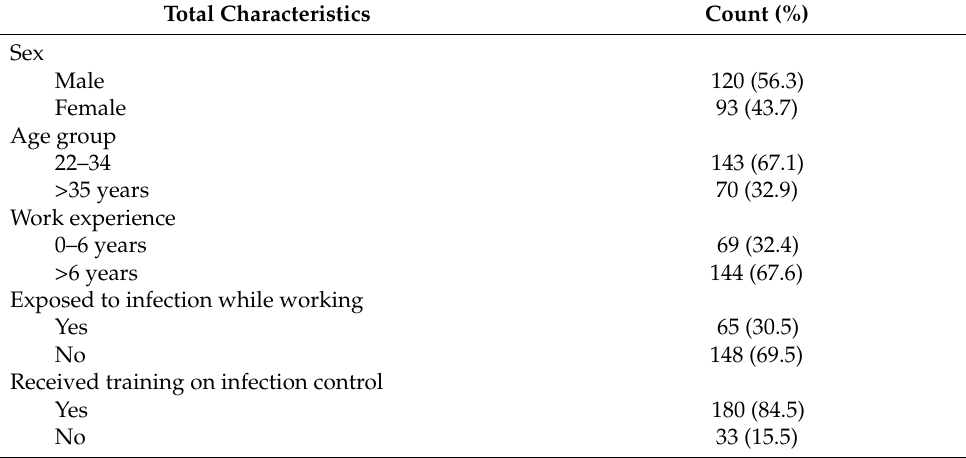
Table 1. Socio-demographics characteristics of HCWs, assessment of KAP of standard infection control precautions, Qassim University Hospital, KSA.